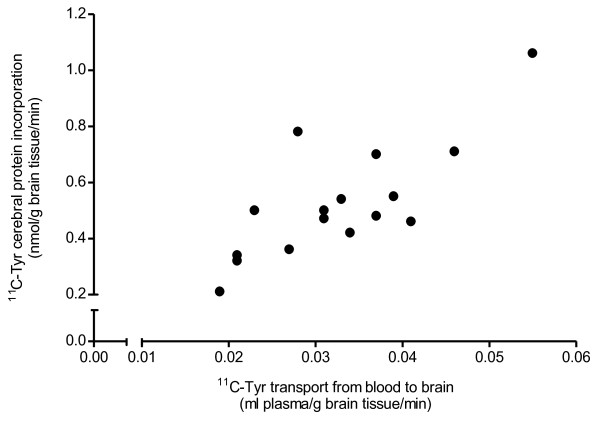
Relation between 11C-Tyr cerebral protein incorporation and 11C-Tyr transport from blood to brain.